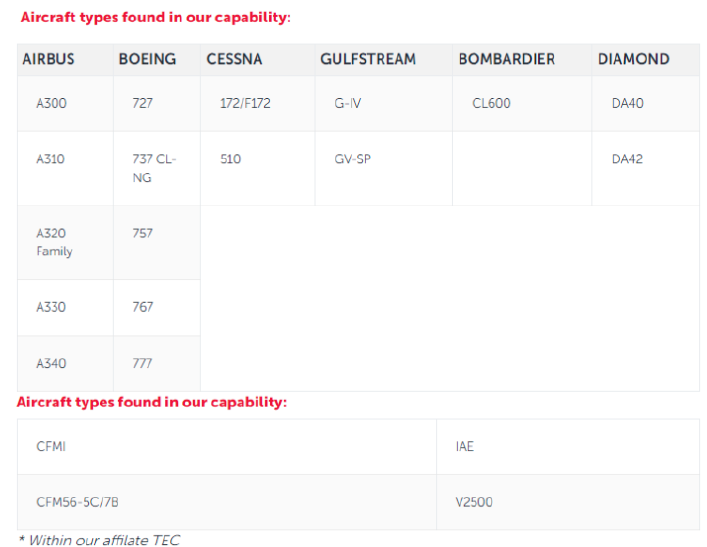
Figure 7: Turkish Airlines Technic Capabilities; Source: (Turkish Airlines Technic,